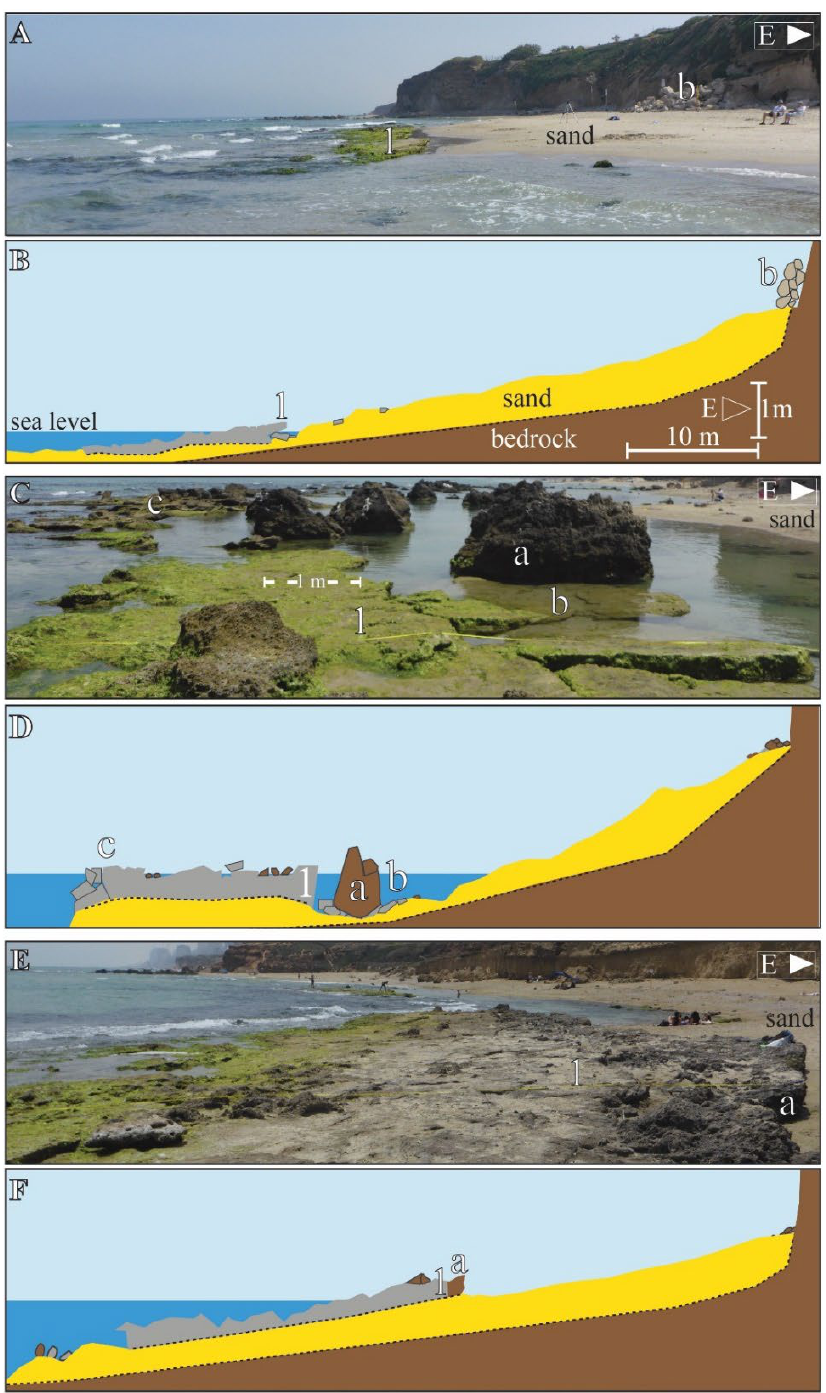
Figure 5. Beachrock exposures north of Netanya and south of Alexander River outlet: ( A ) view of Havatzelet Hasharon (Netanya site II) ( 1 : BR outcrop, ( b ) artificial ramp); ( B ) schematic cross-section of the site (VE = 4, notes are as in (A), dotted lines mark uncertain depth of unit contacts); ( C ) view of Shoshanat Ha’amakim (Netanya site III) ( 1 : BR outcrop land side front, ( a ) kurkar boulder from cliff collapse, ( b ) beachrock slabs under boulder, ( c ) clast of broken BR boulders); ( D ) schematic cross-section of the site (VE = 4, notes are as in (C), dotted lines mark uncertain depth of unit contacts); ( E ) view of Neurim site ( 1 : BR outcrop, ( a ) elongated friable sandstone front bordering the BR outcrop at land side); ( F ) schematic cross-section of the site (VE = 4, notes are as in (E), dotted lines mark uncertain depth of unit contacts.